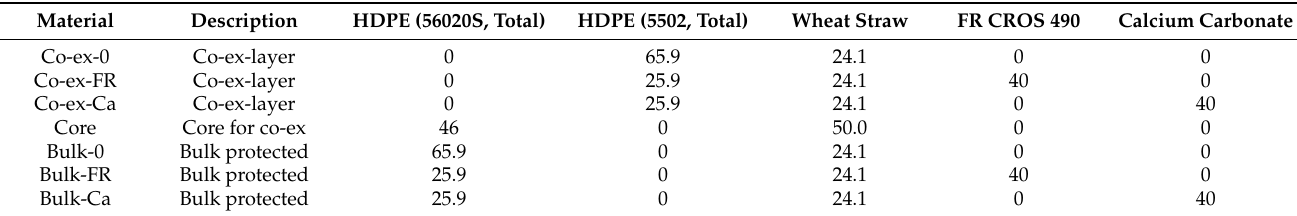
Table 17. Series 2: Formulations for comparison of profiles with FR in the co-extruded layer only or with FR in the bulk. In each case, solid profiles were extruded. Amounts represent wt.%. Each formulation (exception: core for profiles with co-extruded layers) contained 3% MAPE, 4% lubricant, 2.75% color masterbatch, and 0.25% stabilizer (Irganox B225). The core layer for the co-extruded profiles contained only 3% MAPE and 1% lubricant.